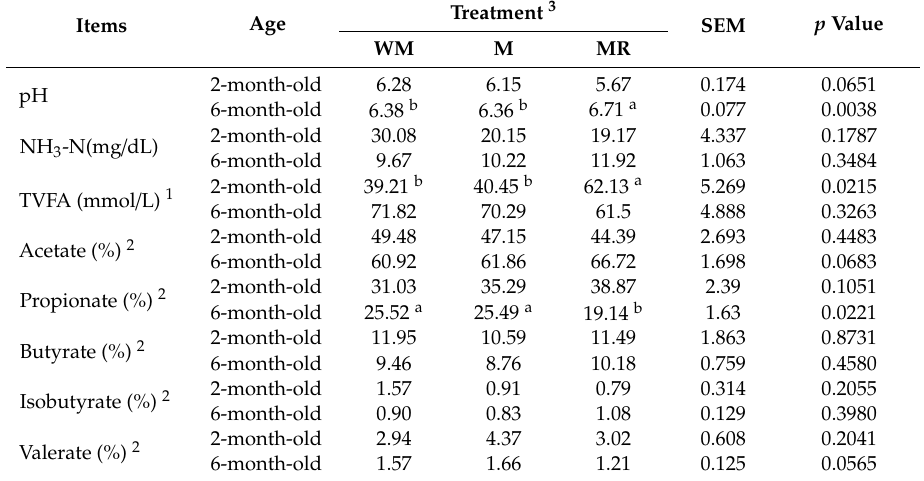
Figure 1. Growth performance of pre-weaning calves (female, n = 15 per each treatment). ( A ) Body weight of calves during 7 to 58 days of age; ( B ) average daily gain (ADG) of calves during 7 to 58 days of age; ( C ) starter intake of calves during 54 to 60 days of age; data are expressed as means ± standard deviation. ab Mean values with different superscripts are different at p < 0.05 according to Duncan’s multiple-range test. Table 4. Rumen fermentation parameters of calves at two and six months of age (female, n = 8 per treatment).